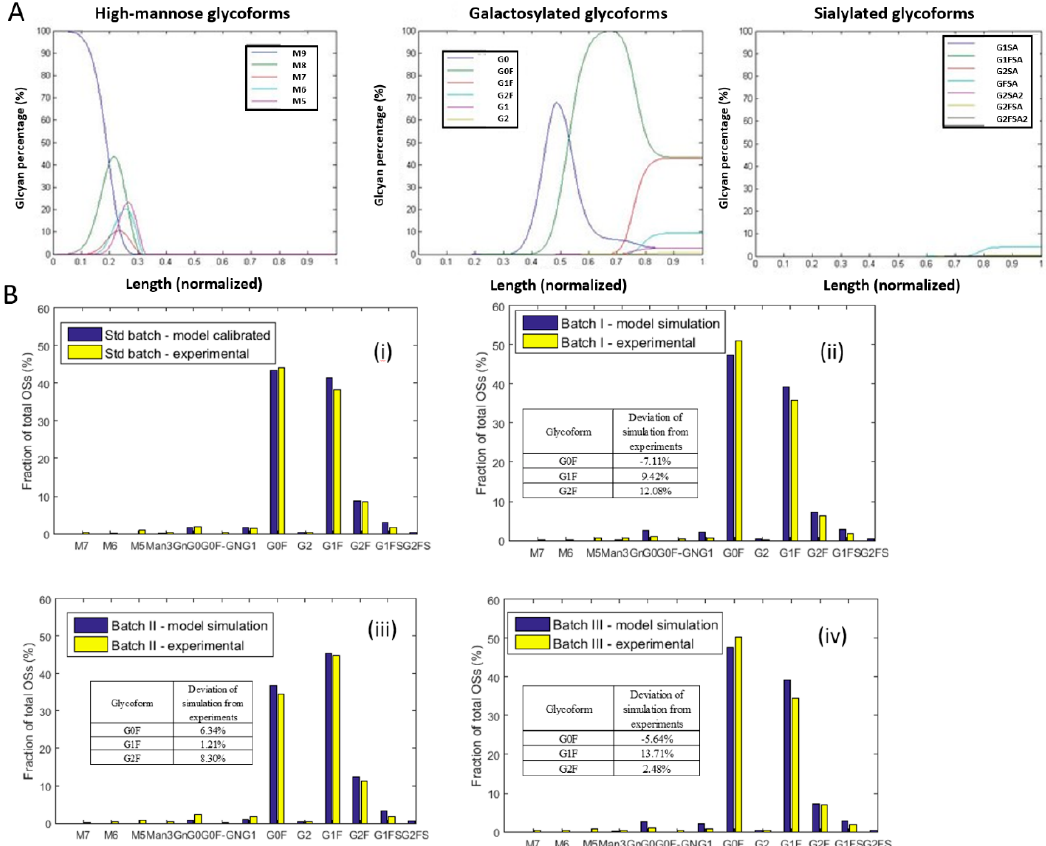
Figure 7. Kinetic model simulation. ( A ) The topological profile of high-mannose (HM), galactosylated